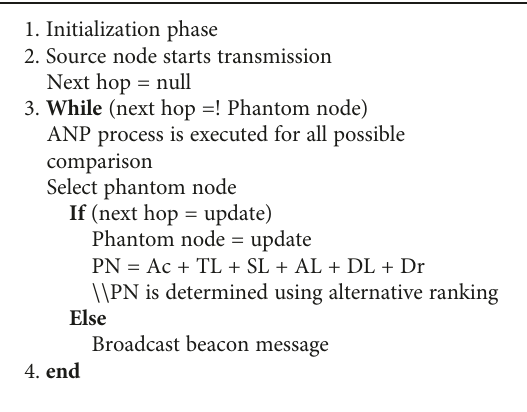
Table 4: Random consistency